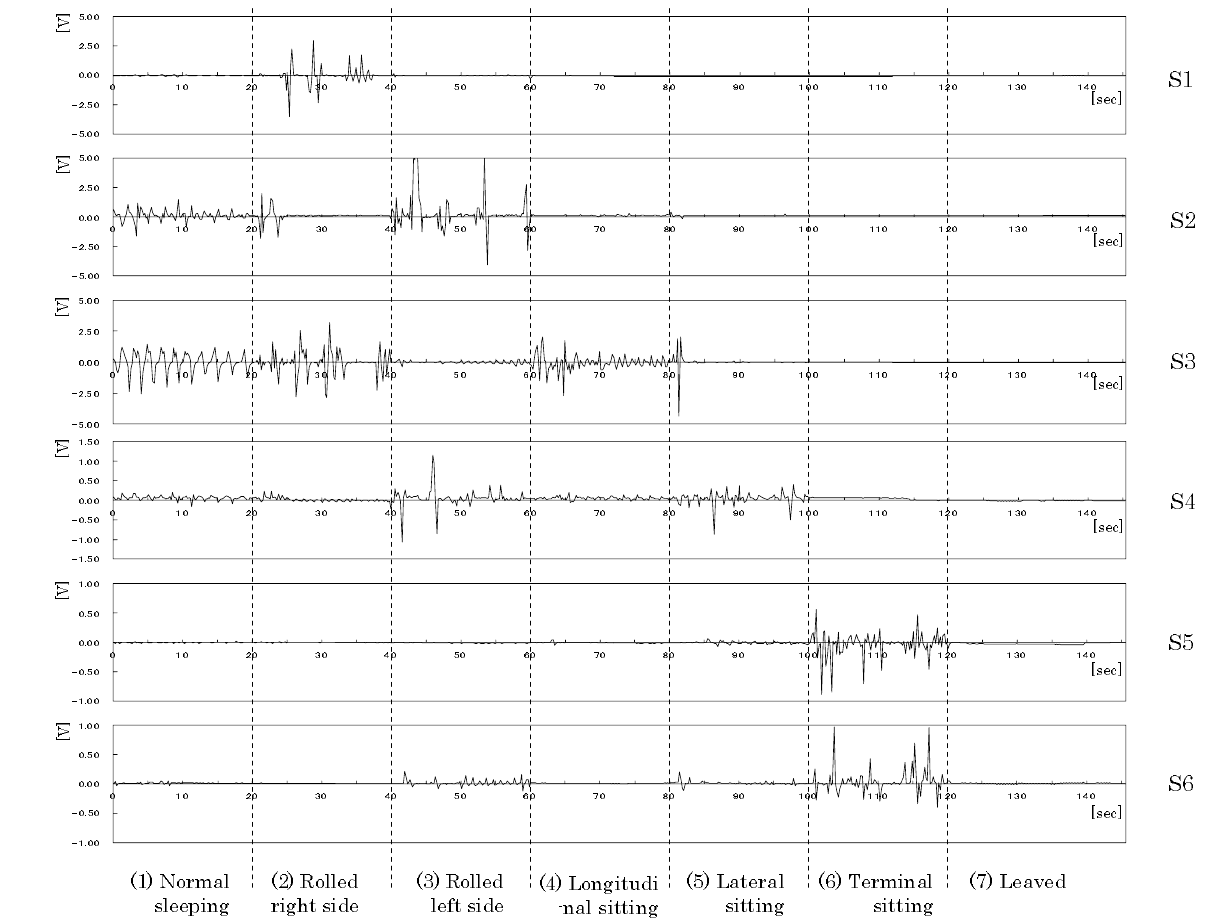
Figure 7. Time-series changes of the sensor output in respective behavior patterns.